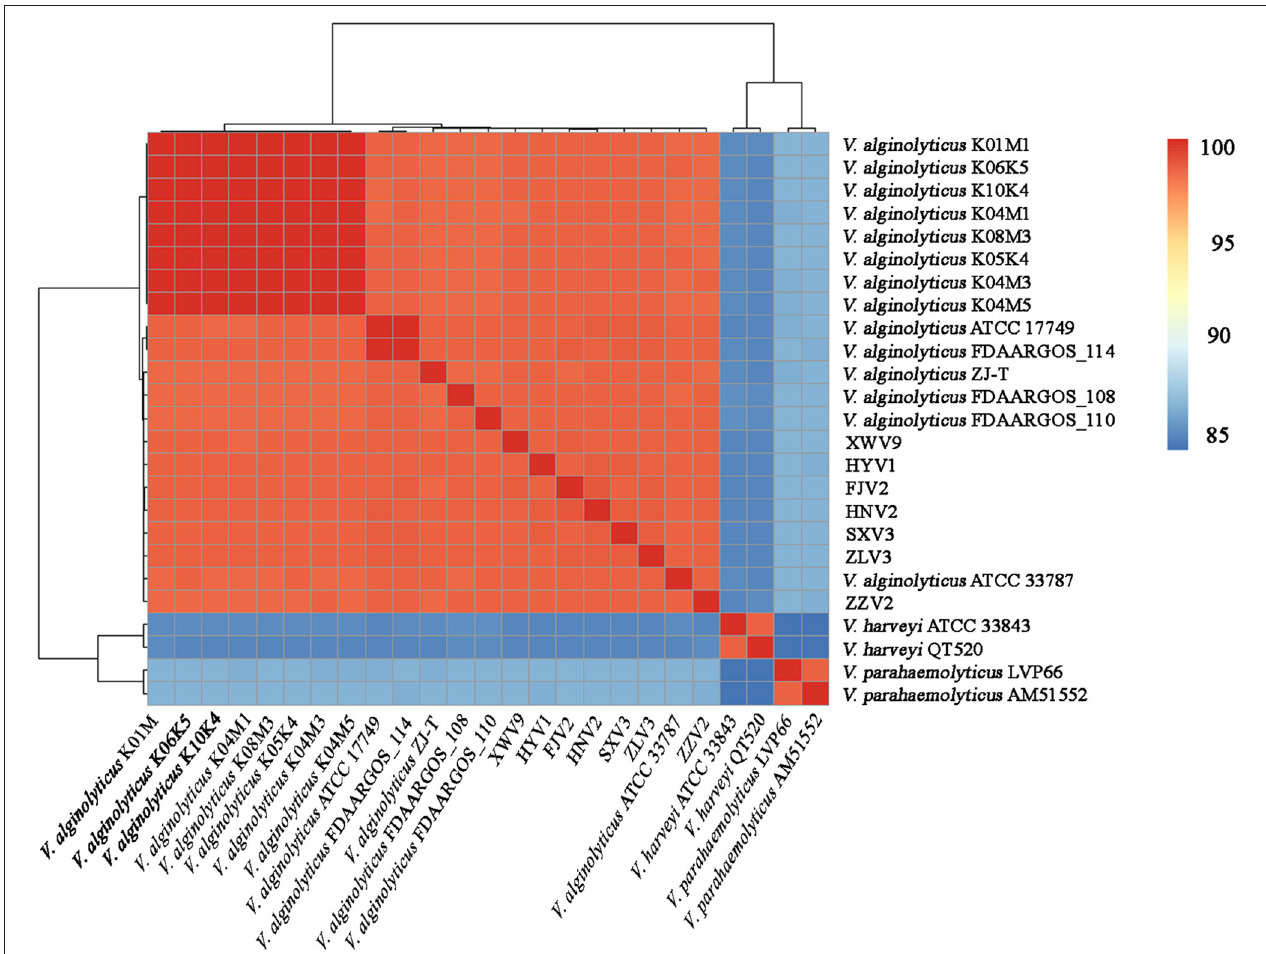
FIGURE 1 | Average nucleotide identity analysis of the complete genomes of 21 V. alginolyticus strains, together with V. harveyi ATCC 33843 and QT520, and V. parahaemolyticus LVP66 and